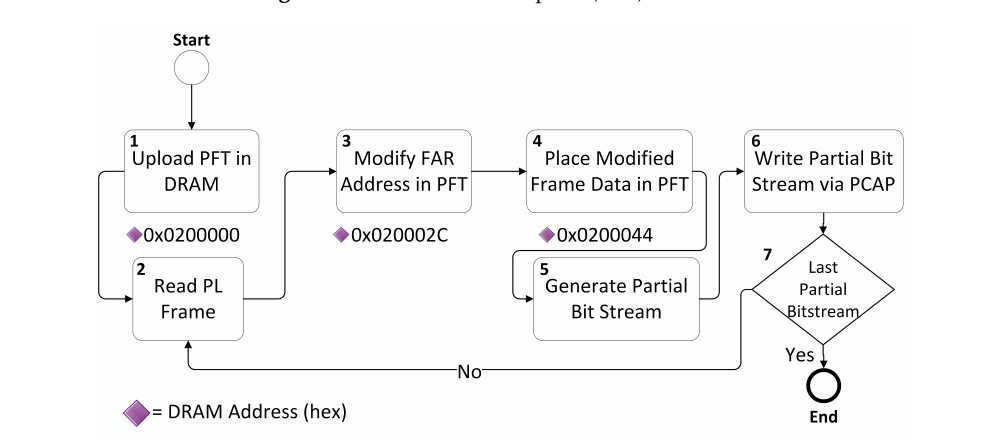
Figure 1. Partial Frame Template (PFT) Structure.